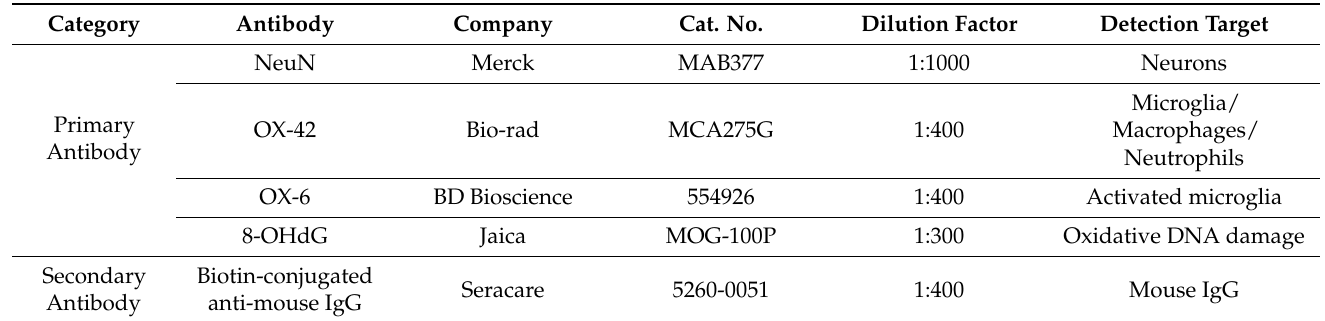
Table 1. Antibodies used for immunohistochemical staining